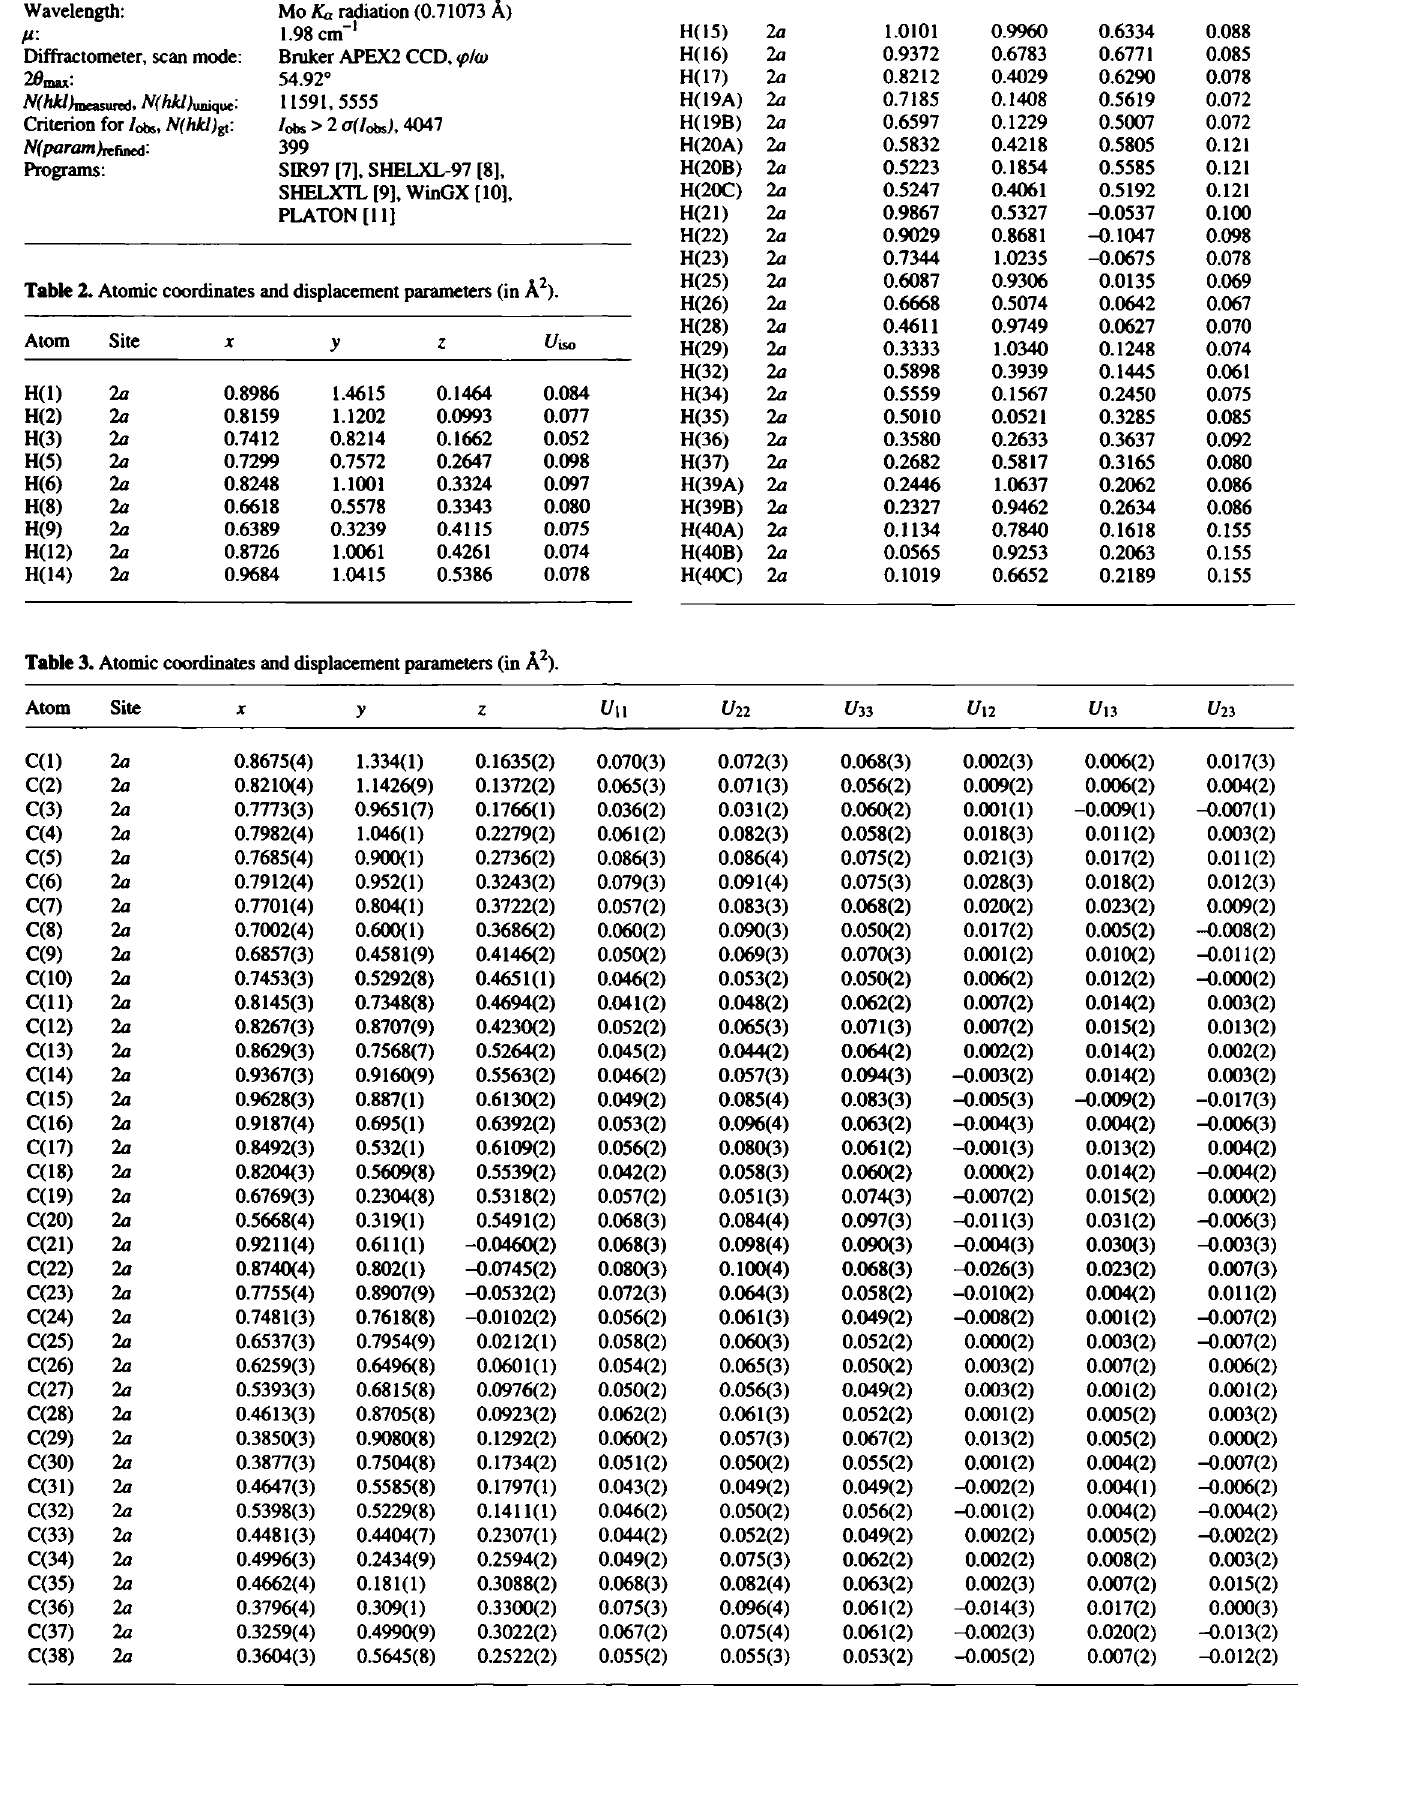
Table 2. Atomic coordinates and displacement parameters (in Â 2 ).